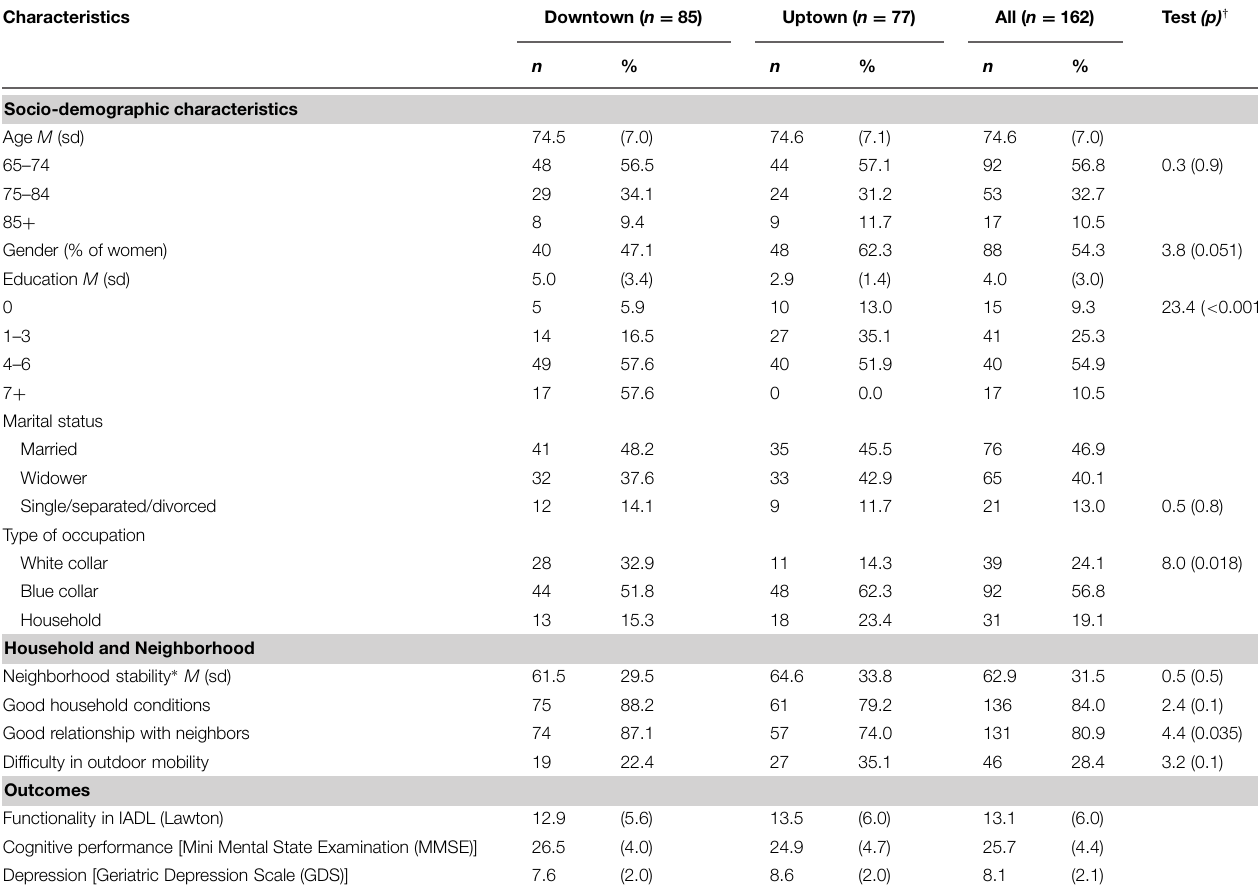
TABLE 1 | Human resources and microenvironment accessibility